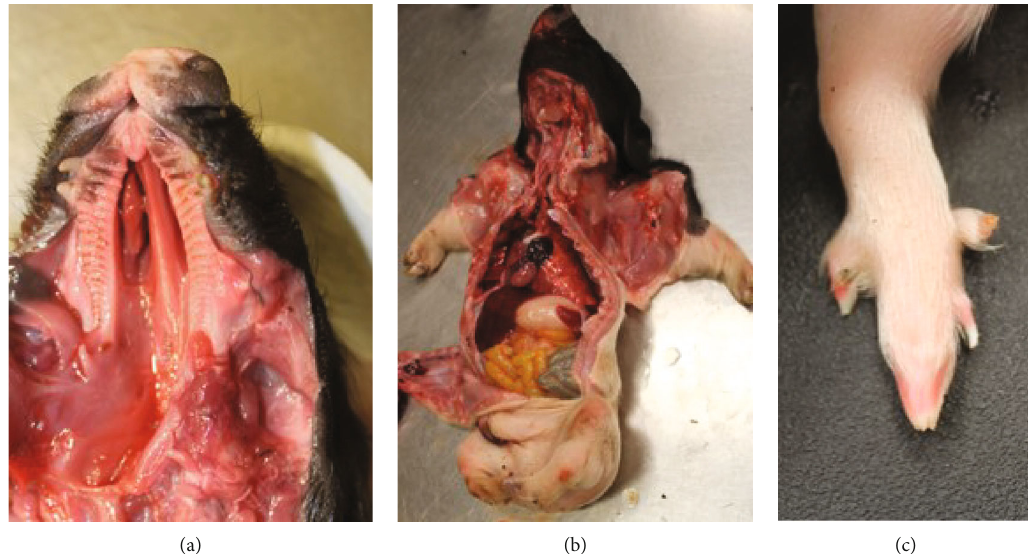
Figure 1: Neonatal pig #1. (a) Bilateral cleft palate with hypoplasia of nasal turbinates. (b) Bilaterally shortened hindlimbs. (c) Syndactyly with dewclaws and vestigial nonossi fi ed keratin